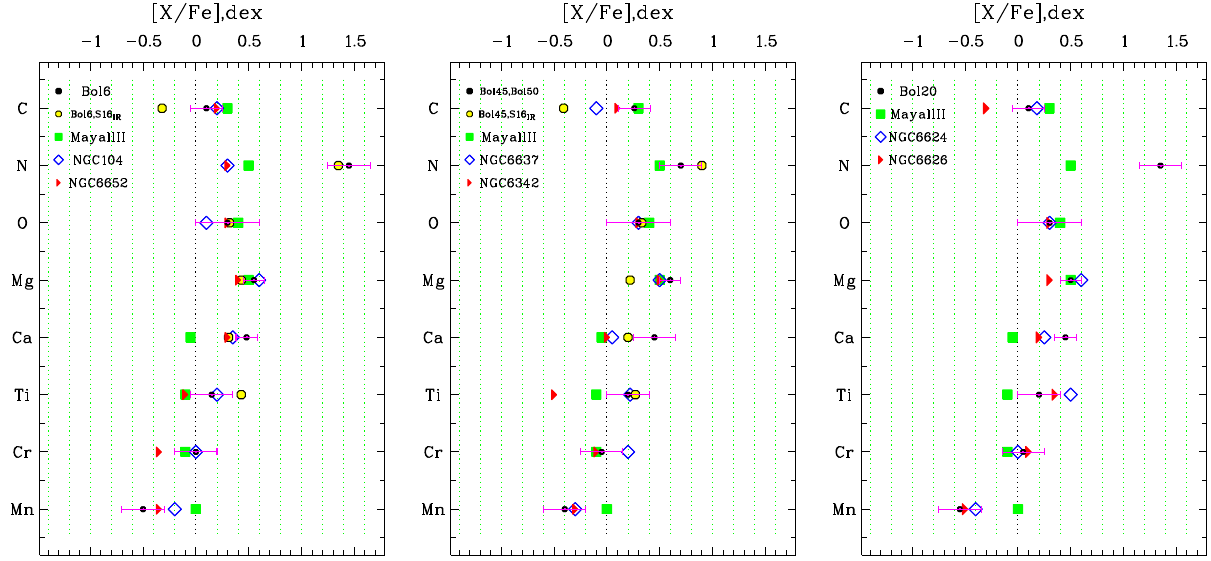
Figure 7: Abundances of chemical elements determined by MMI21 for Bol 6 ( left panel ) , Bol 45 and Bol 50 ( middle panel ) , and Bol 20 ( right panel ) using the method of Sharina et al . ( 2020 ) ( black dots ) in comparison with the high - resolution integrated - light spectroscopic abundances from S16 ( open circles ) and with the abundances for Galactic GCs from Sharina et al . ( 2018, 2020 ) ( symbols de fi ned in the up left corners of the plots ) . Note that MMI21 derived the identical abundances for Bol 45 and Bol